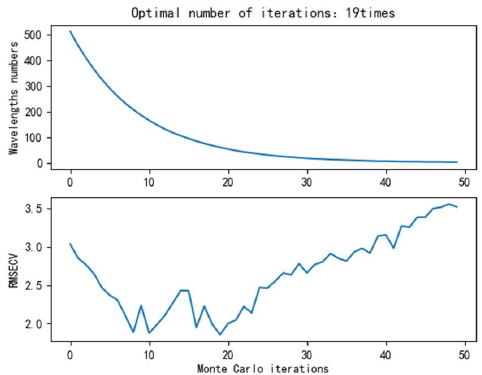
Figure 11. CARS feature selection results.